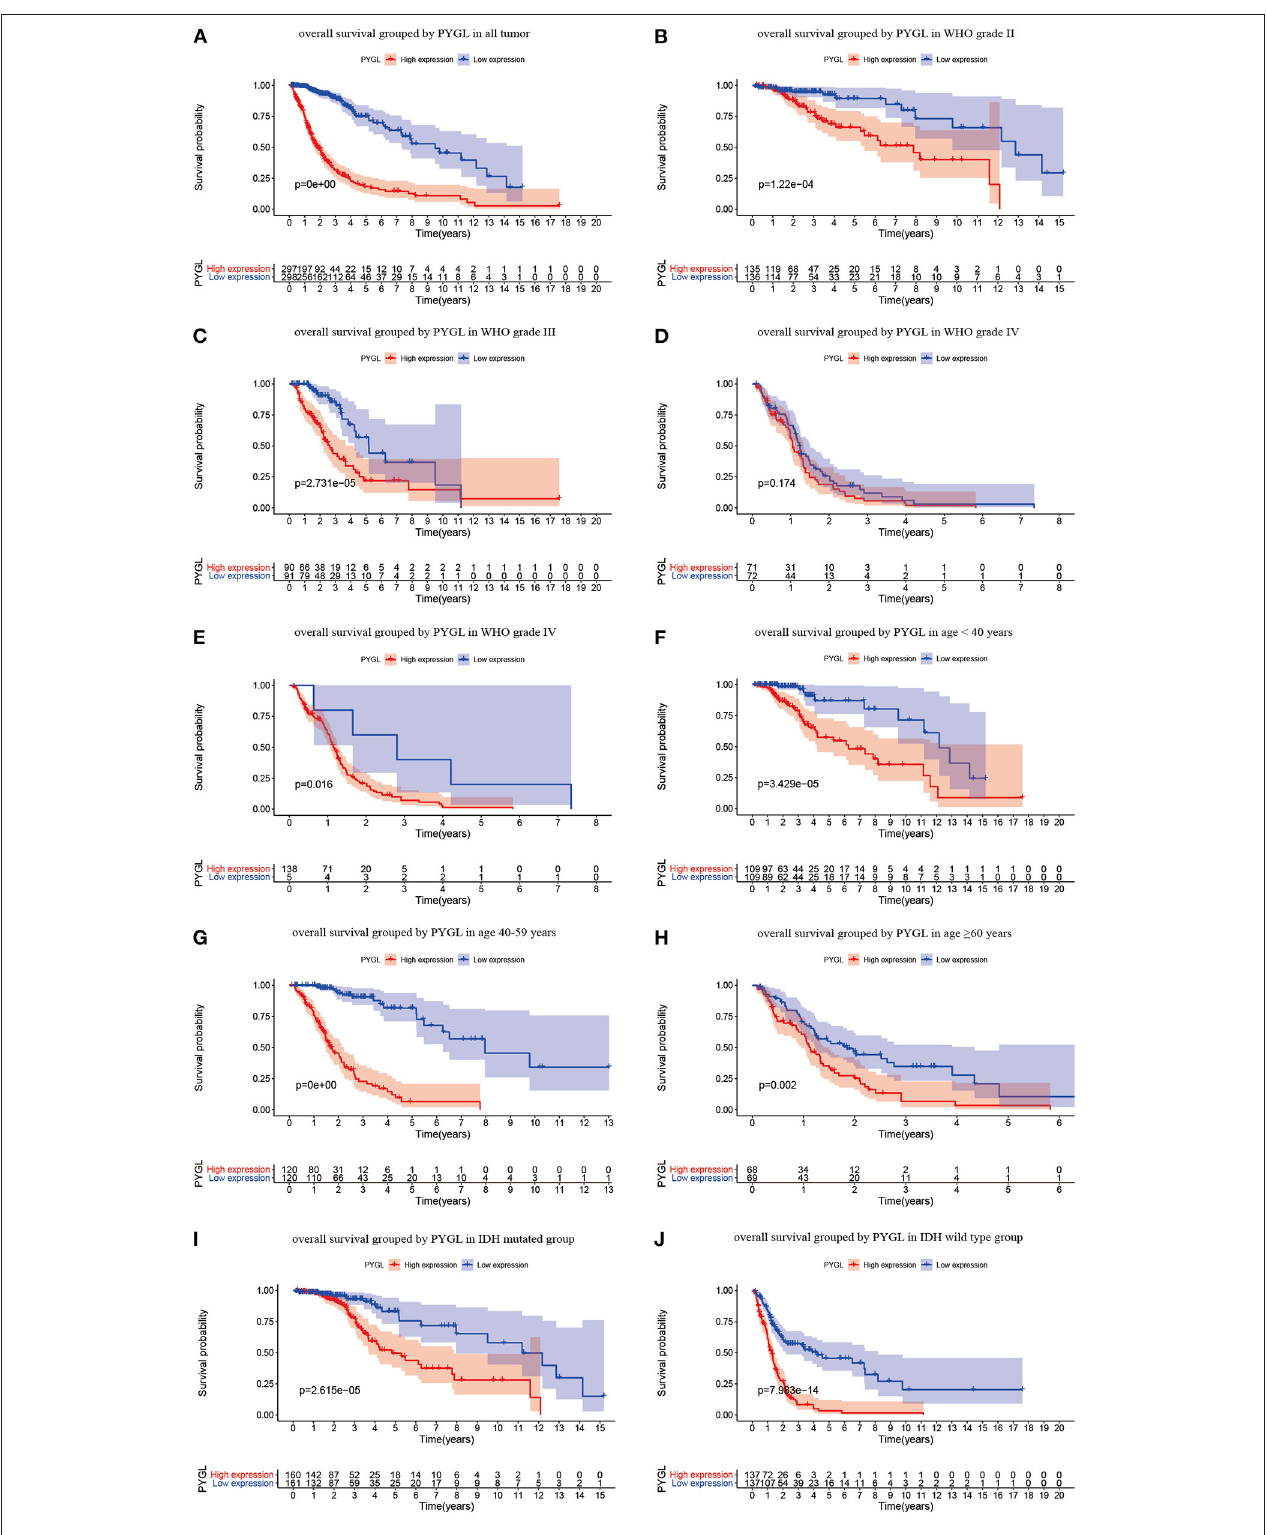
FIGURE 2 | Kaplan-Meier (KM) survival curves for OS in glioma. (A) KM curves for OS in glioma for all cases. (B) KM curves for OS in gliomas of WHO grade II. (C) KM curves for OS in gliomas of WHO grade III. (D) KM curves for OS in glioma of WHO grade IV with the median of PYGL expression in gliomas of WHO grade IV as a threshold. (E) KM curves for OS in gliomas of WHO grade IV with the median of PYGL expression in all cases as a threshold. (F) KM curves for OS in gliomas of age < 40 years. (G) KM curves for OS in gliomas of age 40–59 years. (H) KM curves for OS in gliomas of age ≥ 60 years. (I) KM curves for OS in gliomas with IDH mutation. (J) KM curves for OS in gliomas with IDH wild